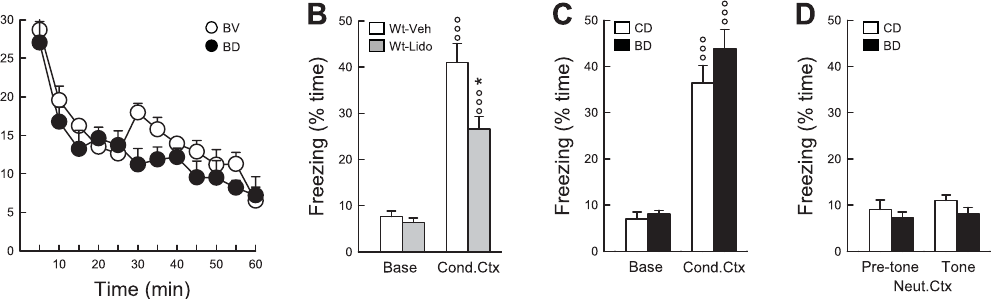
Figure 5. Effects of adult hippocampal neurogenesis ablation on simple forms of spatial knowledge. ( A ) Exploration in a novel environment measured by photocell beam breaks. ( B ) Contextual fear conditioning assessed by the percentage of freezing displayed by C57BL/6J wild-type (Wt) mice before conditioning (Base) and when re-exposed 24 hours later to the conditioning context (Cond.Ctx). Mice were infused with Vehicle (Veh) or lidocaine (Lido) in the dorsal hippocampus before conditioning. ( C ) Contextual fear conditioning assessed by the percentage of freezing displayed by control (CD) and bigenic mice (BD) treated with doxycycline in the basal condition and when re-exposed to the conditioning context 24 hours later. ( D ) Fear conditioning assessed by the percentage of freezing displayed 24 hours after conditioning by CD and BD mice when exposed to a neutral context (Neut.Ctx) before (Pre-tone) and during (Tone) re-exposure to the tone present during conditioning but unpaired with the shock. BV=bigenic-vehicle mice. uuu : p # 0.001 compared to Base. *: p # 0.05 compared to